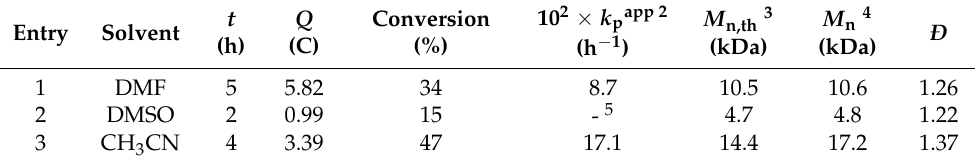
Table 2. Potentiostatic e ATRP of 50% ( v / v ) styrene in different solvents at T = 80 ◦ C 1 . Table 2. Potentiostatic e ATRP of 50% (v/v) styrene in different solvents at T = 80 °C 1. Table 2. Potentiostatic e ATRP of 50% (v/v) styrene in different solvents at T = 80 °C 1. Table 2. Potentiostatic e ATRP of 50% (v/v) styrene in different solvents at T = 80 °C 1. Entry Solvent Entry Solvent